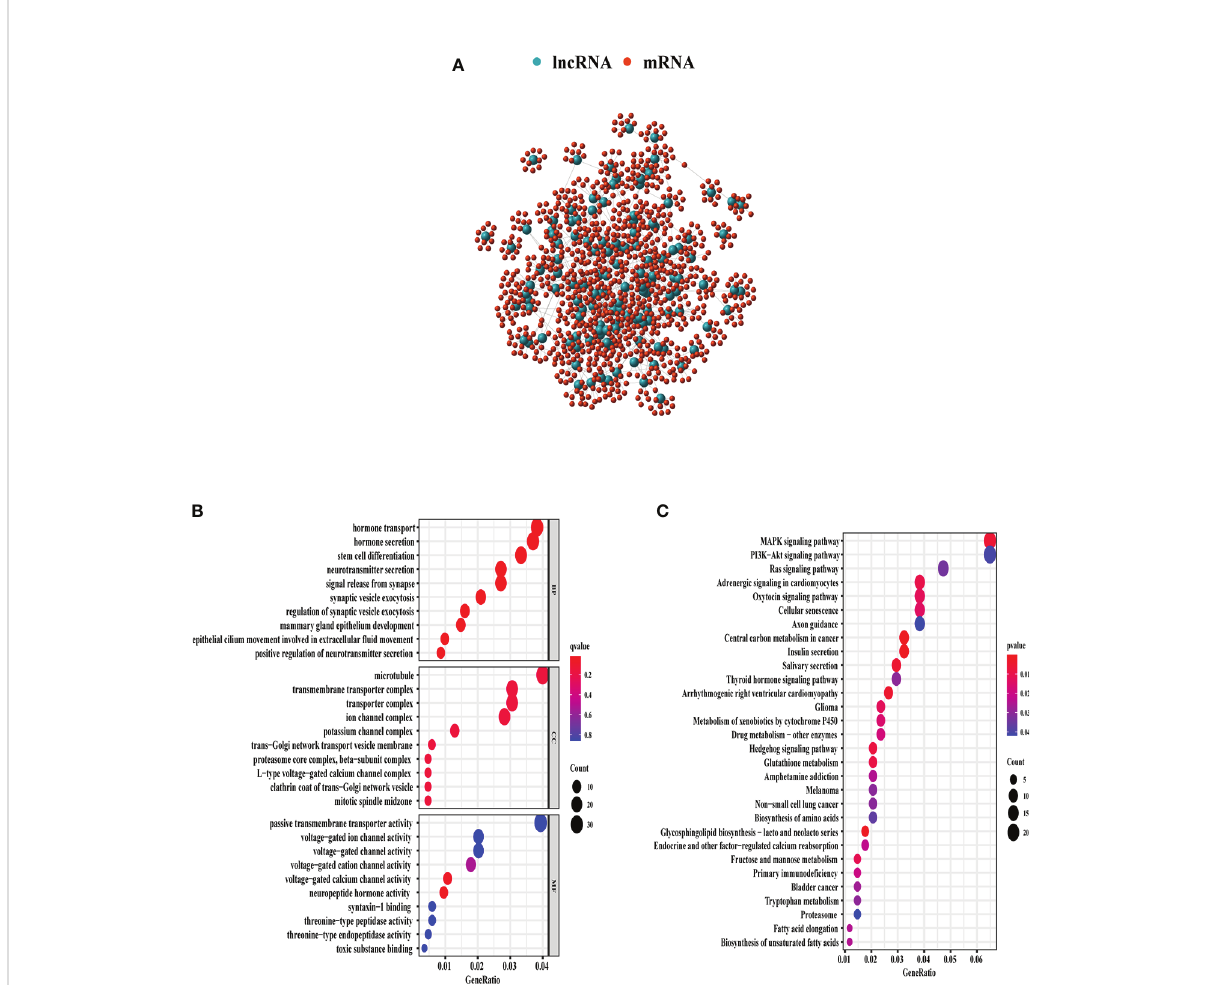
FIGURE 3 GO and KEGG enrichment analyses of 1,280 genes related with 128 lncRNAs demonstrated in the bubble plot. (A) The 1,280 genes related to 128 lncRNAs. (B) The top 10 enriched terms of BP, CC, and MF in GO analysis. (C) The top 30 enriched terms in KEGG analysis. The bubble size shows the count of related genes enriched under each term. GO, gene ontology; BP, biological process; CC, cellular component; MF, molecular function; KEGG, Kyoto Encyclopedia of Genes and